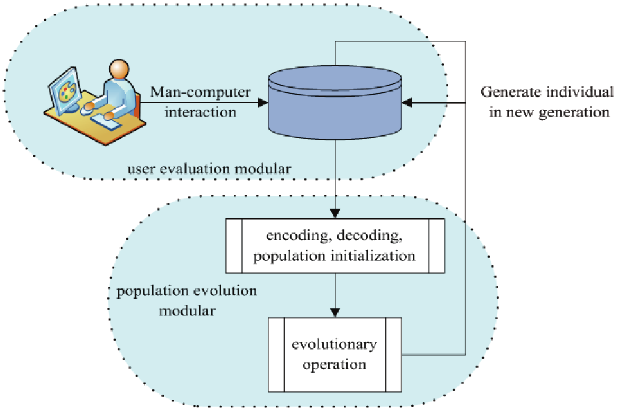
Fig.1. Schematic Diagram of Interactive Genetic Algorithm